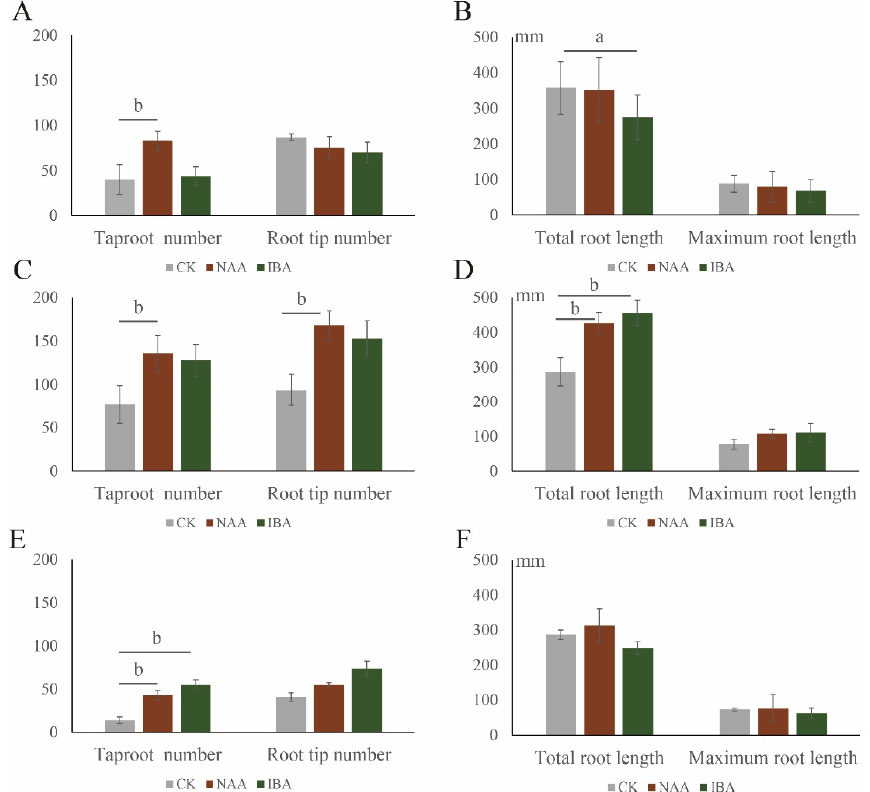
Figure 2. Rooting efficiency for air layering of tree peony when different growth regulators (IBA and NAA) were supplied at the concentration 1000 mg/L. The evaluation was carried out for three tree peony varieties: ‘Baoqing Hong’ ( A , B ), Quehao ( C , D ) and Xishi ( E , F ). A control treatment (no growth regulators applied = CK) was considered for each variety. a indicates significant differences, 0.01 < p < 0.05; and b indicates highly significant differences, 0.01 < p < 0.05.